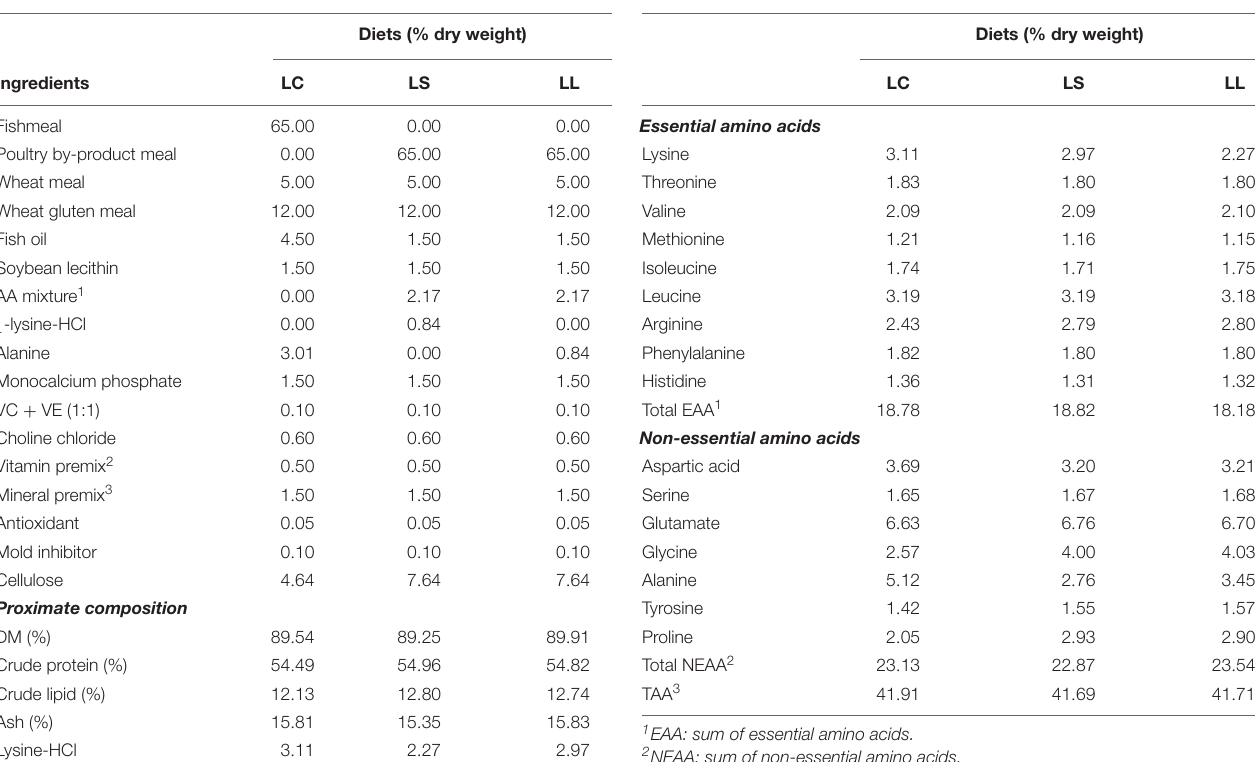
TABLE 1 | Experimental diet formulations. TABLE 2 | Amino acid composition of experimental